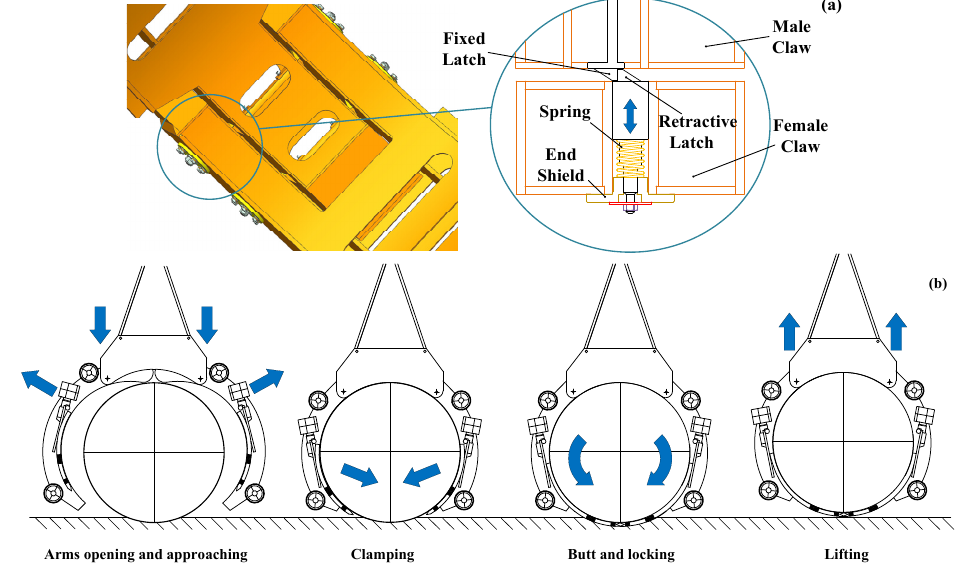
Figure 4. Working principle and process of the butting and locking mechanism: ( a ) Locking and unlocking principle and ( b ) Working principle of Manipulator.